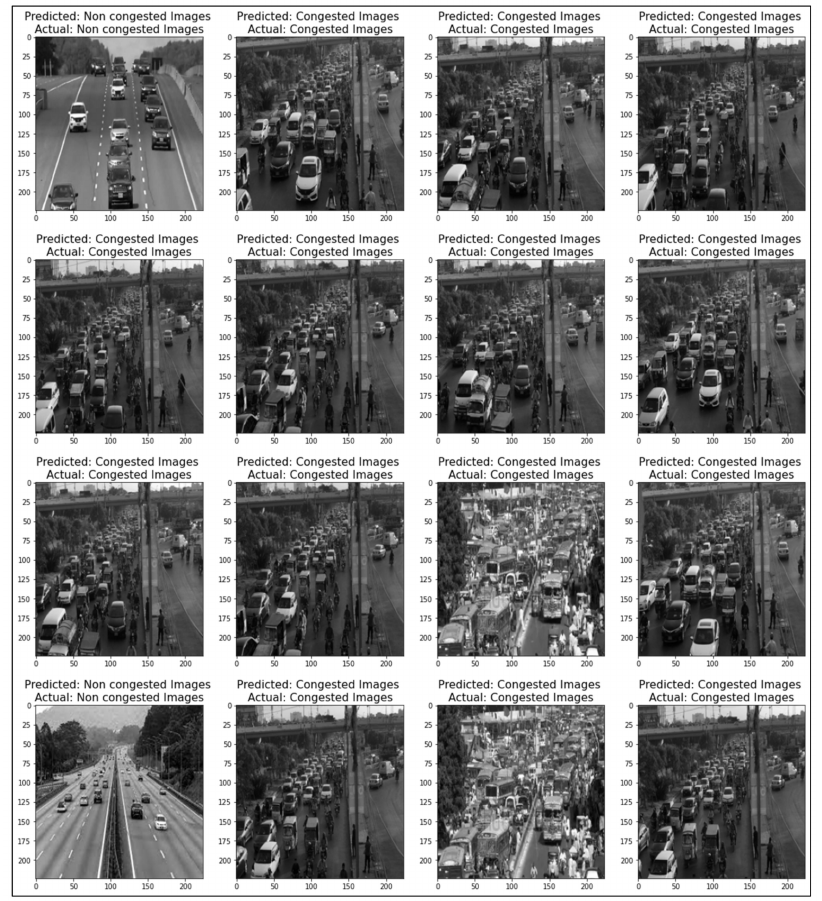
Figure 10. Images showing the trained model’s predictions for the congestion and non-congestion